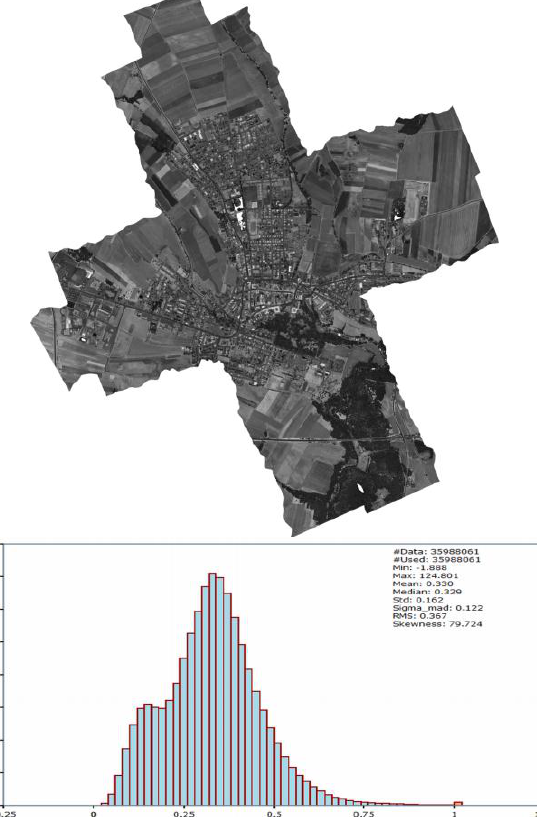
Figure 4. Upper image: Calibrated radiometric reflectance at 1550nm (linear scale from 0 (black) to 1 (white)); Lower image: Histogram of calibrated radiometric reflectance